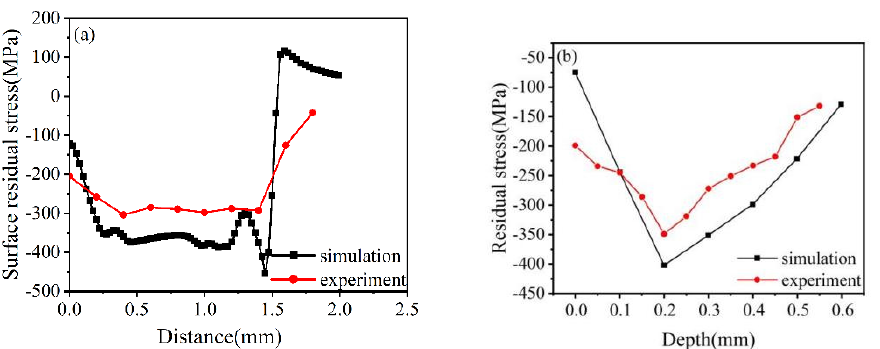
Figure 5. Simulation and experimental residual stress comparison: ( a ) surface orientation; ( b ) depth orientation.